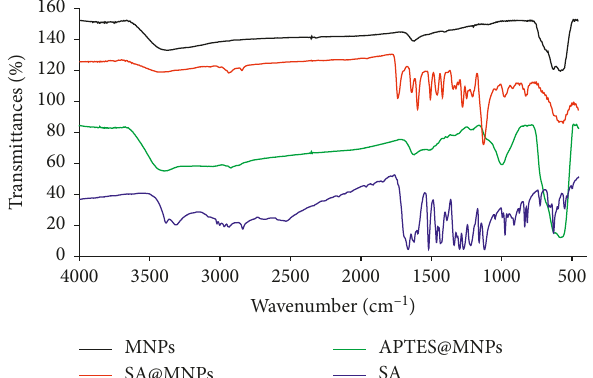
Figure 2: FT-IR spectra of MNPs, SA, APTES@MNPs, and SA@